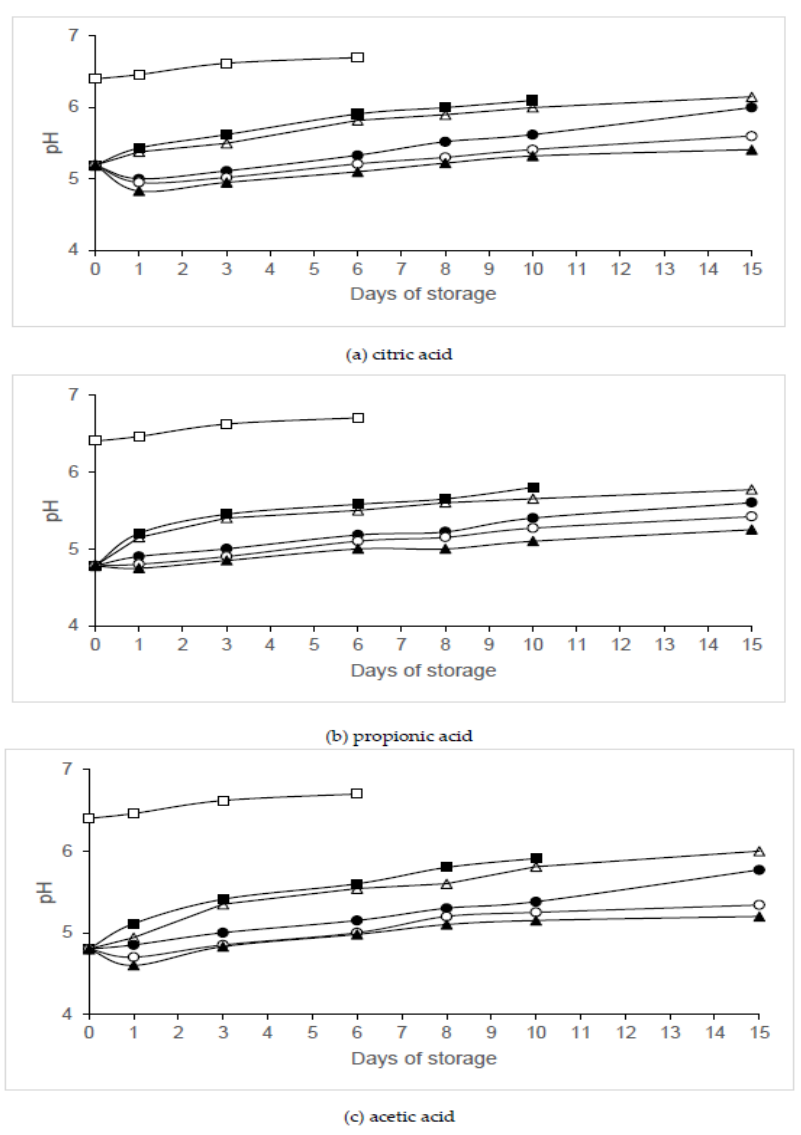
Figure 8. Evolution of pH in chicken legs treated with organic acids and packaged under modified atmospheres. Treatment conditions: Batch C, distilled water and packaging in air ( □ ); 2% organic acid, packaging in air ( ▪ ); 2% organic acid, packaging in 80% N 2 /20% CO 2 ( • ); 2% organic acid, packaging in 60% N 2 /40% CO 2 ( ◦ ); 2% organic acid, packaging in 40% N 2 /60% CO 2 ( ▲ ); 2% organic acid, packaging under vacuum ( ∆ ). ( a ) Citric acid; ( b ) propionic acid; ( c ) acetic acid. Data shown are each the mean value of six determinations.